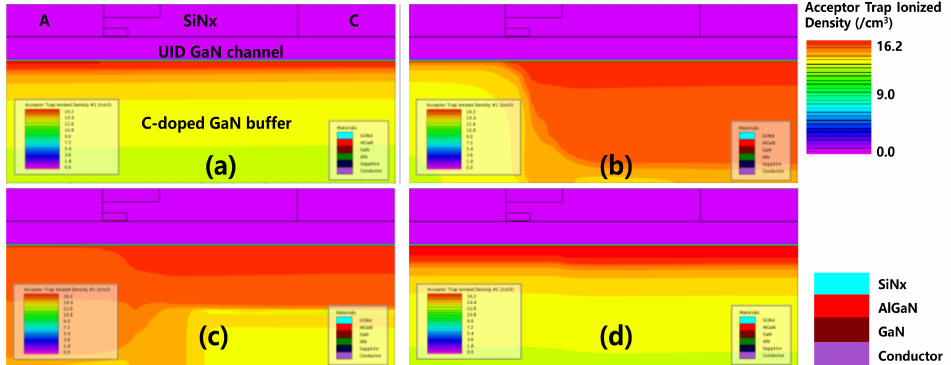
Figure 7. Ionization concentration of the acceptor traps distribution at different timings. ( a ) t 0 : the initial state; ( b ) t 1 ; ( c ) t 2 ; and ( d ) t 3 .